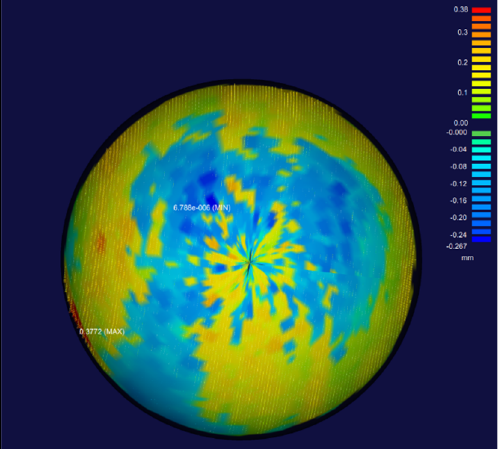
Figure 17. Deviation analysis between the standard sphere model and the scanned point cloud. In Figure 17, the parts from green to red represent positive deviation, and the parts from green to blue represent negative deviation. The result shows that the error of the point cloud near the edge of the standard sphere is relatively large, the maximum positive deviation is 0.38 mm, and the maximum negative deviation is − 0.27 mm. The possible reason for this is that the data obtained at the edge of the scanner is relatively unstable due to the limitation of the scanner principle. The geometric standard deviation is 0.043 mm, showing that the overall deviation is more evenly distributed. 4.4. System S patial Measurement Accuracy Experiment In order to determine the spatial measurement accuracy of the system, several meas- urement experiments are carried out with the standard parts. The standard parts used mainly include a standard sph ere with a diameter of 30.0055 mm and a standard gauge block with a length of 70 mm. The accuracy of standard parts is 0.0015 mm. To verify the reliability of the standard part data, ten measurement experiments were carried out on the standard ball and standard gauge block using a three-coordinate measuring machine (CMM). The model of the bridge-type CMM is Global 09.15.08 from Hexagon, and the indication error is 1.2 µm. Figure 18 shows photos of the process of using CMM to meas- ure the standard part, and Table 5 records the data of the diameter of the standard ball and the length of the standard gauge block measured by CMM. ( a ) ( b ) Figure 18. Images of CMM measuring standard parts. ( a ) Measuring standard sphere. ( b ) Measuring standard gauge block.